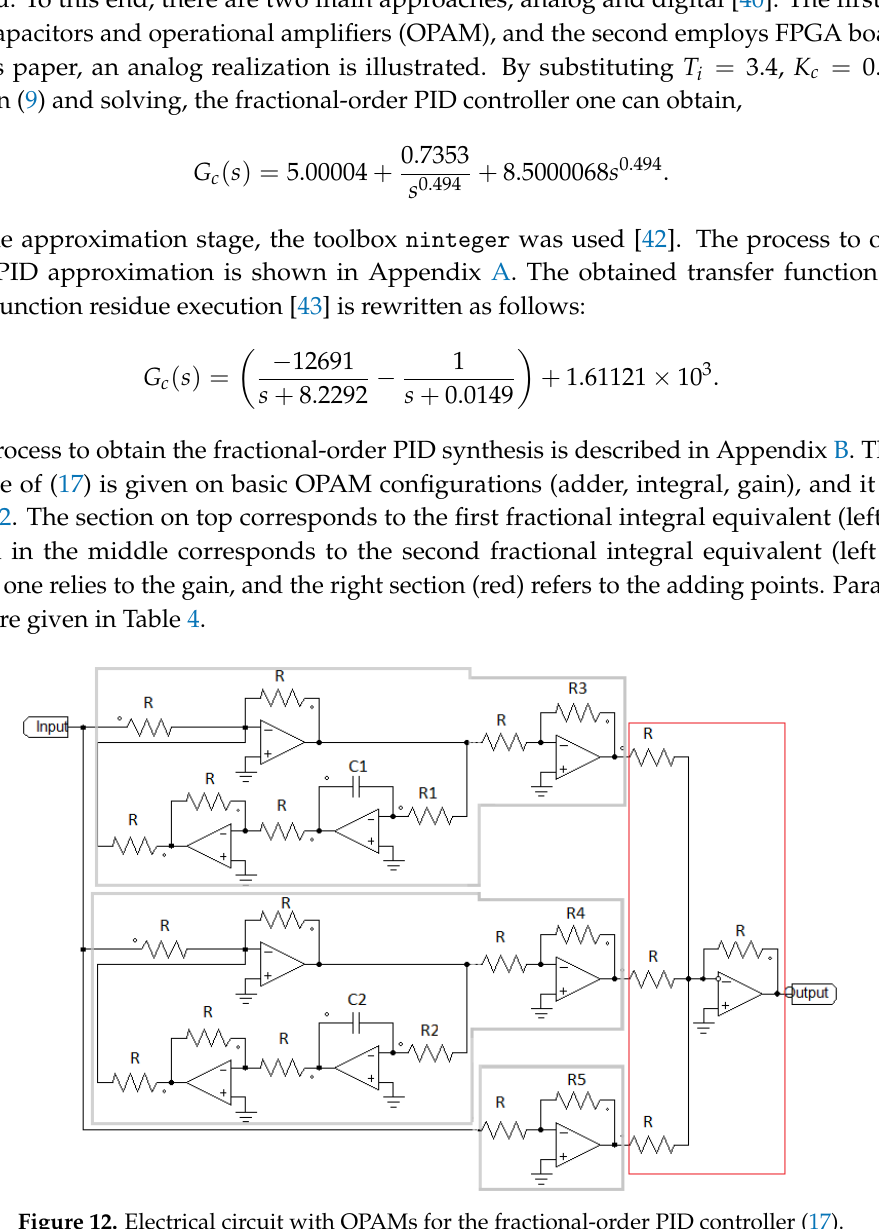
Figure 12. Electrical circuit with OPAMs for the fractional-order PID controller (17). Table 4. Parameter values for the electrical circuit with OPAMs of Figure